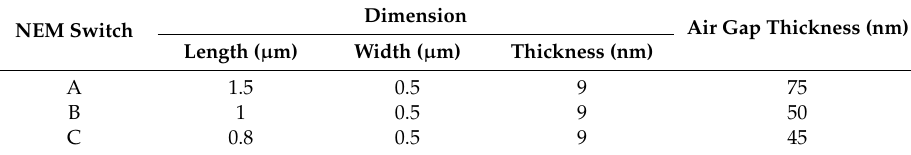
Table 1. NEM switch dimensions.